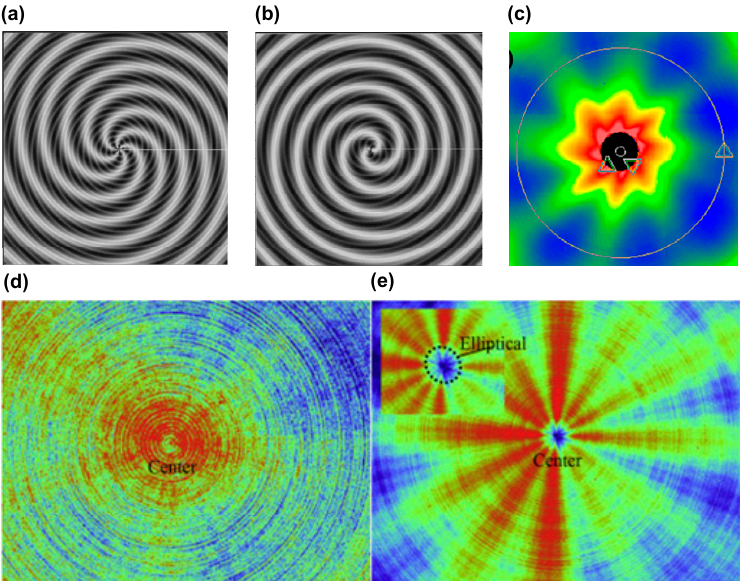
Figure 7. Results of surface topography on mono- and multi-frequency vibration conditions: ( a ) simulation results of surface topography on mono-frequency vibration condition ( ∆ = 5, ε = 0.2); ( b ) simulation results of surface topography on mono-frequency vibration condition ( ∆ = 2, ε = − 0.2); ( c ) experimental results on the mono-frequency vibration condition; ( d , e ) experimental results on the multi-frequency vibration condition. Reproduced with permission from [75,76,79].